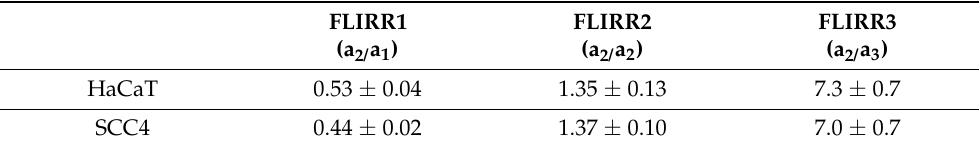
Table 5. FLIRR indices of HaCaT and SCC4 cells derived by a three-exponential fit of the flavins with fixed lifetime values, τ 1 = 250 ps, τ 2 = 1.4 ns and τ 3 = 5 ns. The NAD(P)H decay was fitted biexponentially using the fixed lifetimes τ 1 = 400 ps and τ 2 = 2.5